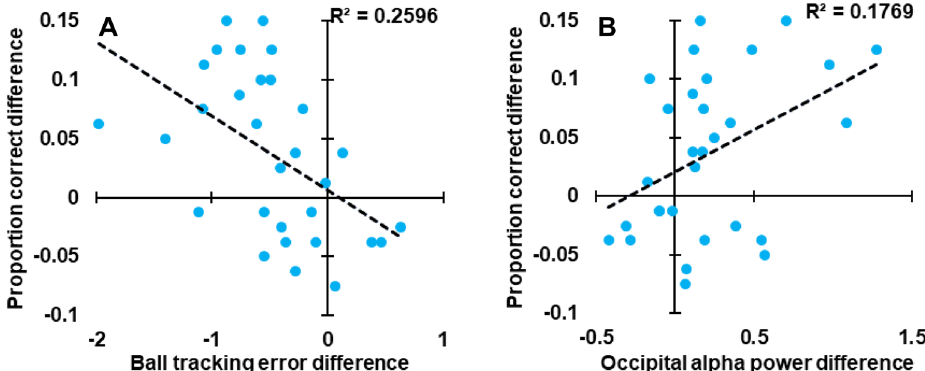
Figure 4. Conditional differences (upright minus inverted) in proportion correct as a function of differences in (A) ball tracking error and (B) occipital alpha power, in the last 500 ms of each video, for each